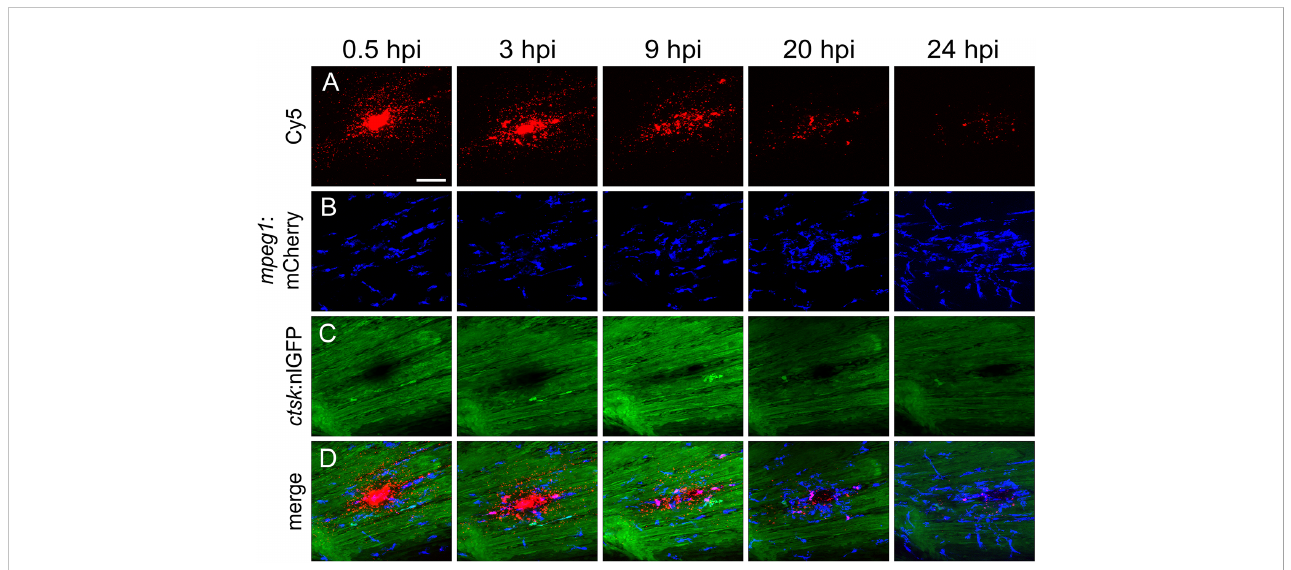
FIGURE 4 Macrophages are recruited to the injection site and internalize CaP nanoparticles within 24 hours. Cy5-labelled nanoparticles were injected into the caudal fi n of mpeg1 :mCherry/ ctsk :nlGFP double transgenic medaka larvae at 12 dpf. (A-D) Lateral views of a caudal fi n showing Cy5-labelled nanoparticles (A) , mpeg1 :mCherry positive macrophages (B) , ctsk :nlGFP positive osteoclasts (C) and merged image (D) at 0.5, 3, 9, 20 and 24 hours post injection (hpi), respectively. Scale bar = 40 m m. 3 out of 3 analysed fi sh showed this phenotype.